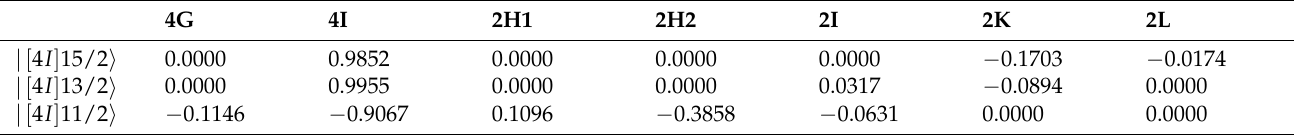
(cid:12) (cid:69) [ 4 I ] 13 (cid:12) , and | [ 4 I ] 11/2 (cid:105) (cid:12) 2